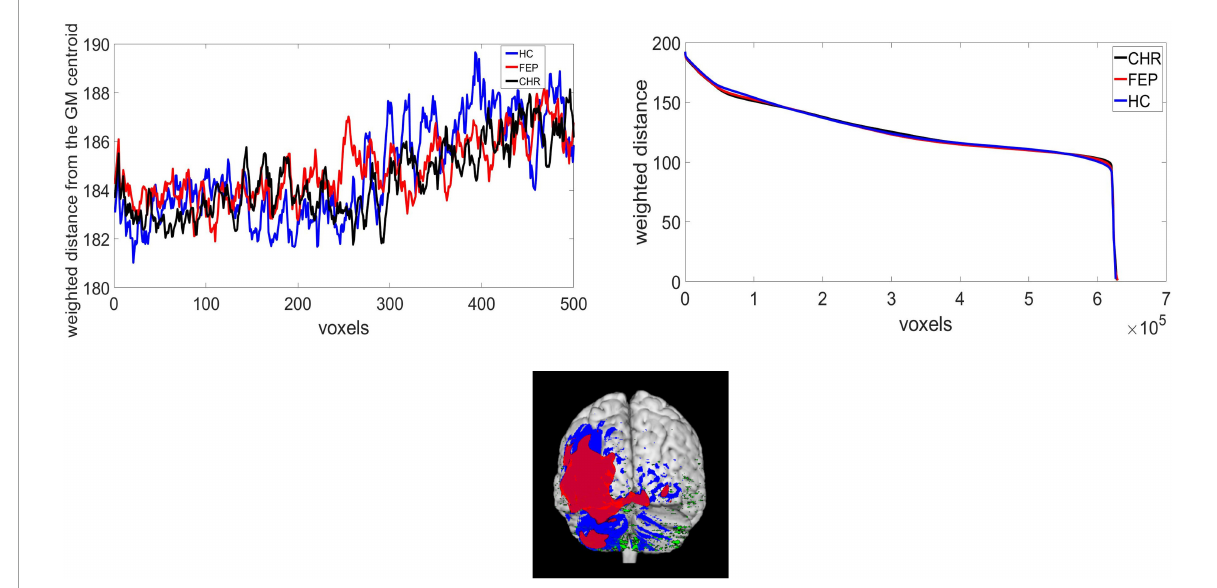
FIGURE1 (A) Weighted distance from the GM center of the mass and voxels, extracted from HC, CHR, and FEP group, (B) the sorted weighted distance and (C) the selected voxels for CHR(red), FEP(blue), and HC(green).